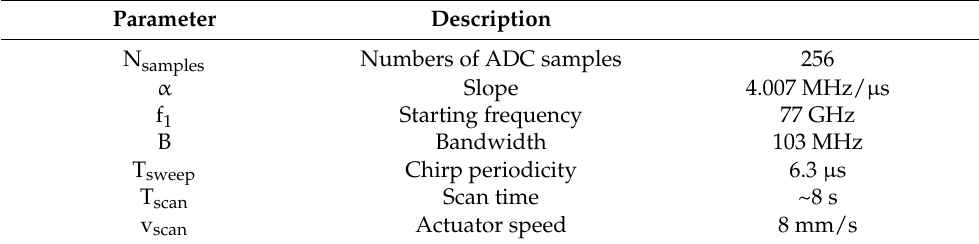
Figure 8. GB-SAR setup during the measurement in the controlled scenario. Table 1. Radar parameters in controlled scenario.